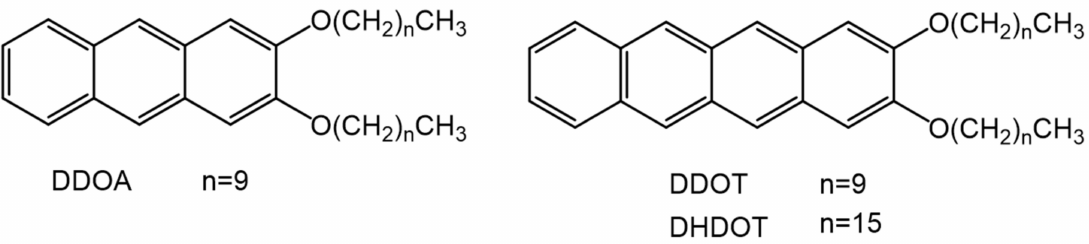
Figure 13. Molecular structures of DDOA, DDOT and